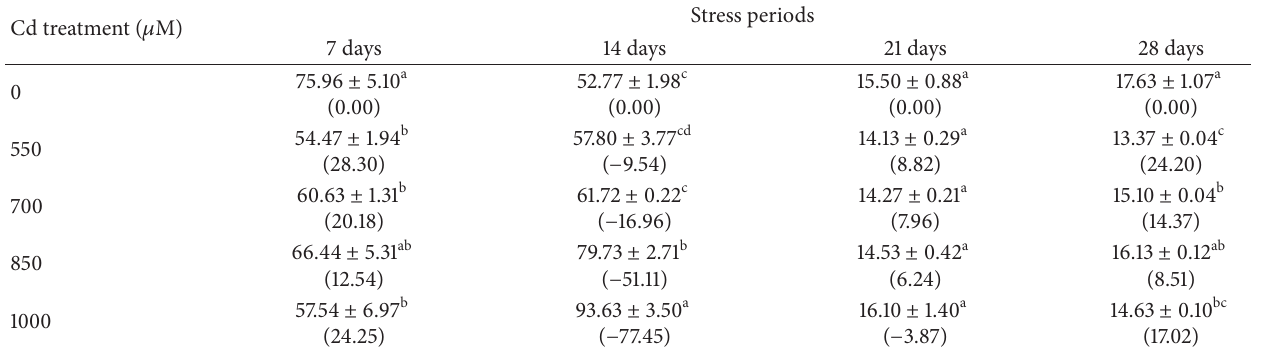
Table 7: POD activity (OD470 g − 1 FW/min) of cotton callus culture (cv. YZ1) grown under various levels of cadmium. Cd treatment ( 𝜇 M)